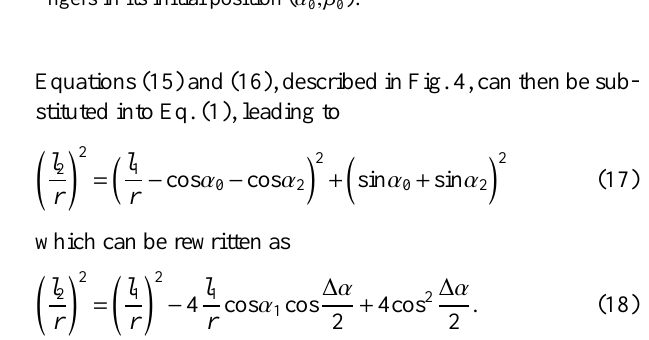
Figure 4. Linkage connecting the metacarpals of the index and ring fingers in its initial position ( α 0 ,β 0